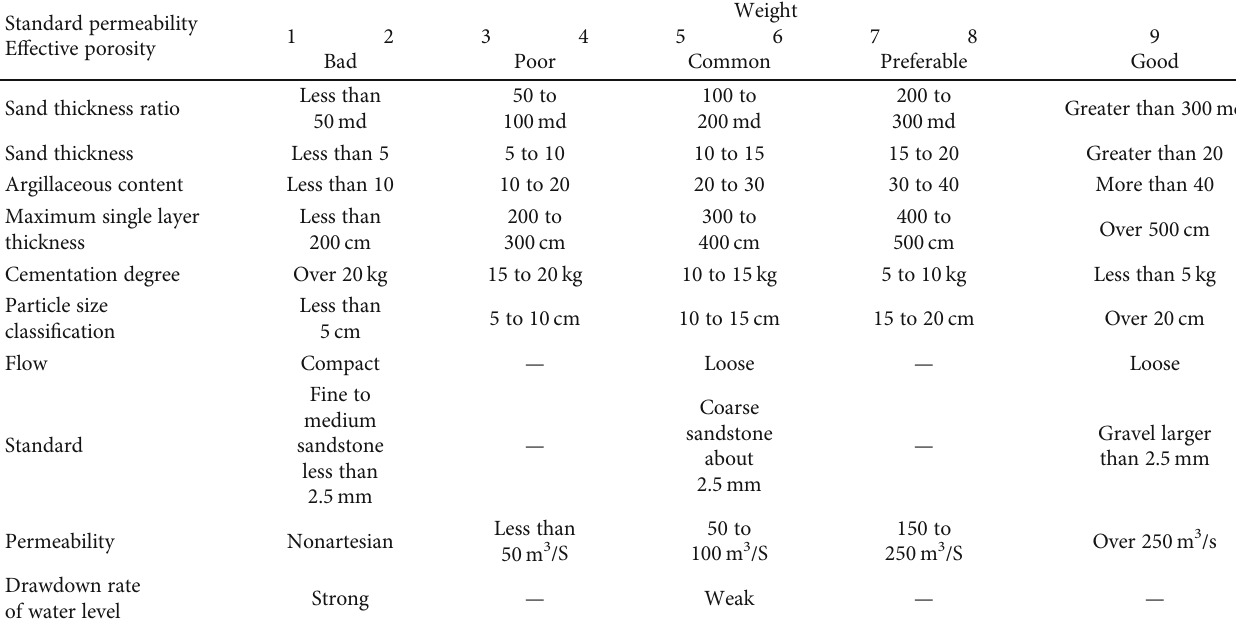
Table 4: Test standard of reinjection e ff ect of heat storage tail water in